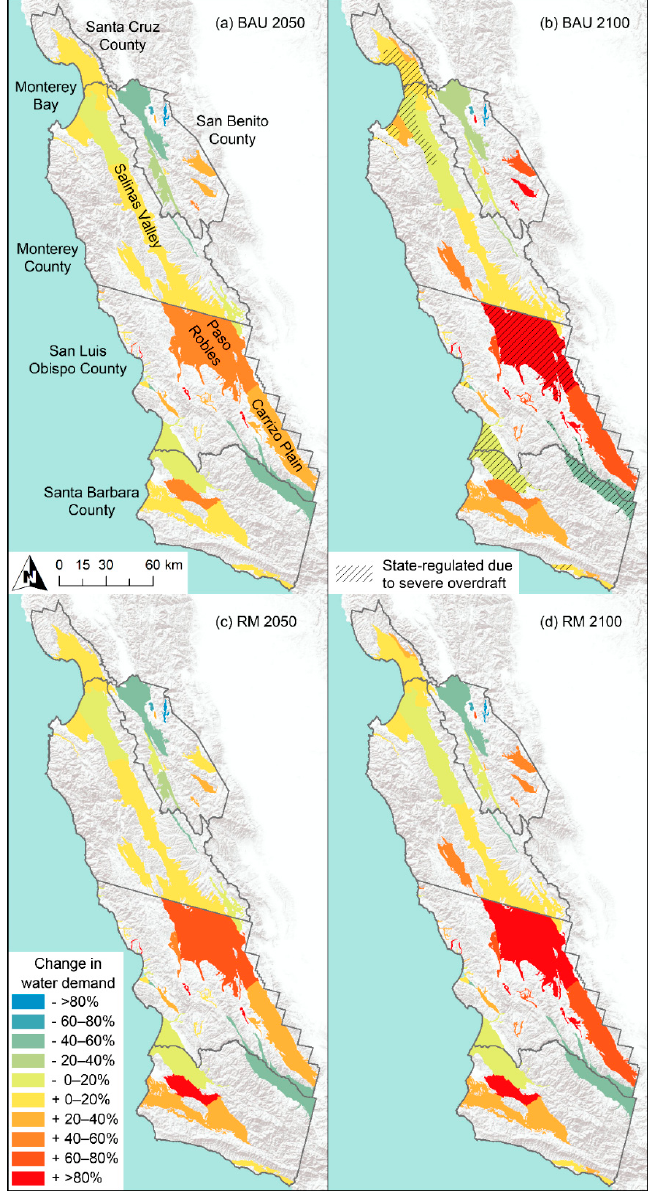
Figure 7. Projected change in water demand for groundwater sub-basins from the ( a ) business-as-usual (BAU) by 2050, ( b ) BAU by 2100, ( c ) recent modern (RM) by 2050, and ( d ) RM by 2100. Hatched lines shown in ( b ) represent existing state-regulated groundwater basins already experiencing overdraft. The base map is from ESRI World Terrain Base [86].